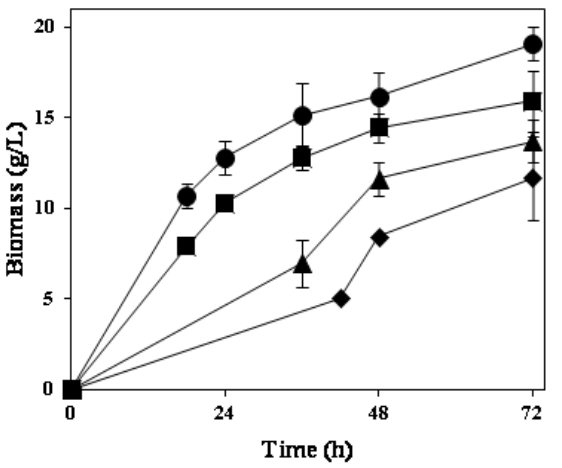
Figure 4. Produced biomass profiles during cultivation of Ascomycetes filamentous fungi in thin stillage at 30 °C. A. oryzae (circles), N. intermedia (squares), F. venenatum (triangles), M. purpureus